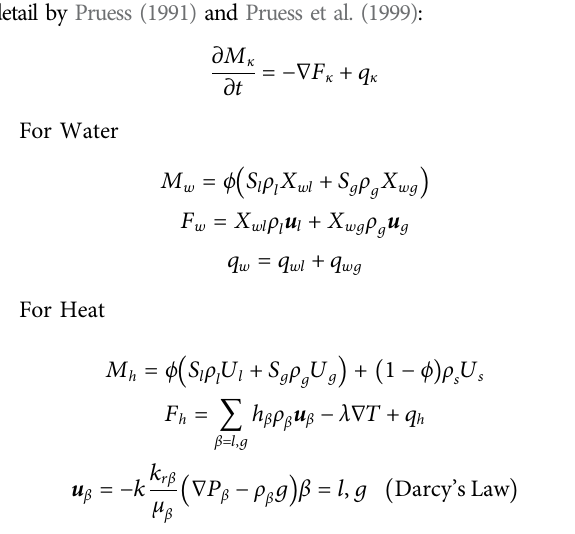
Frontiers in Earth Science |